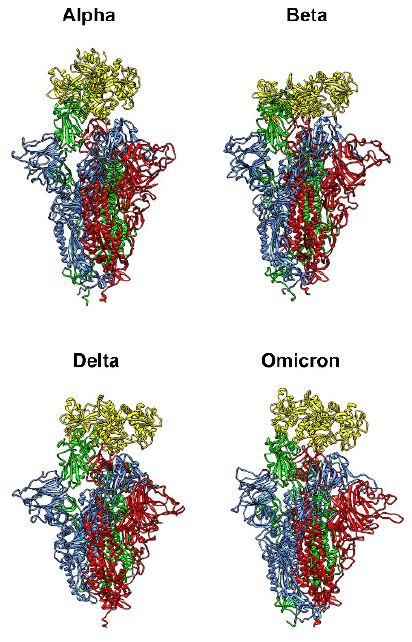
Figure 10. Complex between bovine lactoferrin (bLf) and the four Spike variants of interest obtained through molecular docking simulations. bLf is represented with yellow ribbons, while the three different chains composing the Spike glycoprotein are represented by red, blue, and green ribbons.